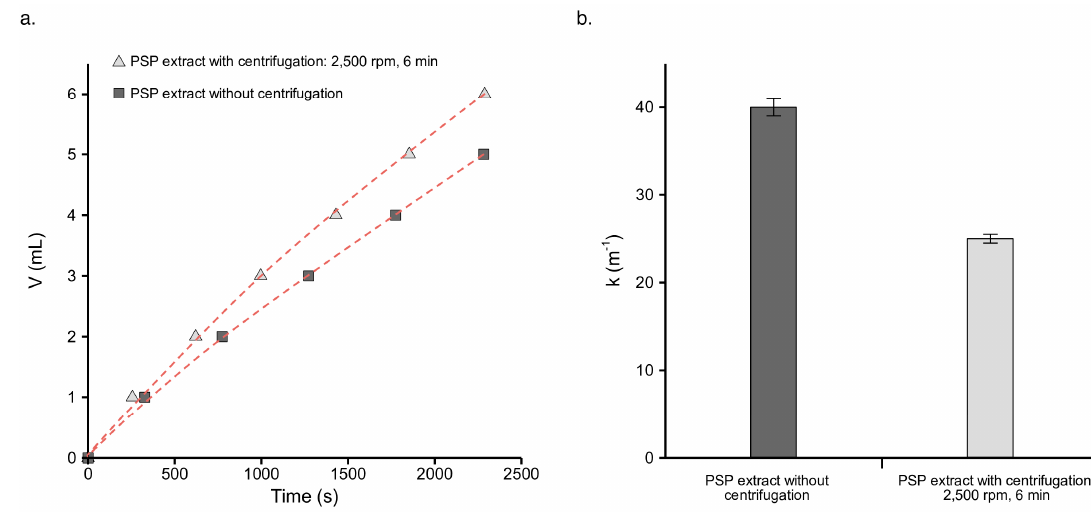
Figure 2. ( a ) Permeate volume versus filtration time. The points represent the experimental data and the dashed lines represent the fitted results after applying Equation (2); and ( b ) fouling coefficient (k) for the filtration of the PSP extract without centrifugation and PSP juice with centrifugation (2500 rpm, 6 min). Error bars correspond to standard deviations.